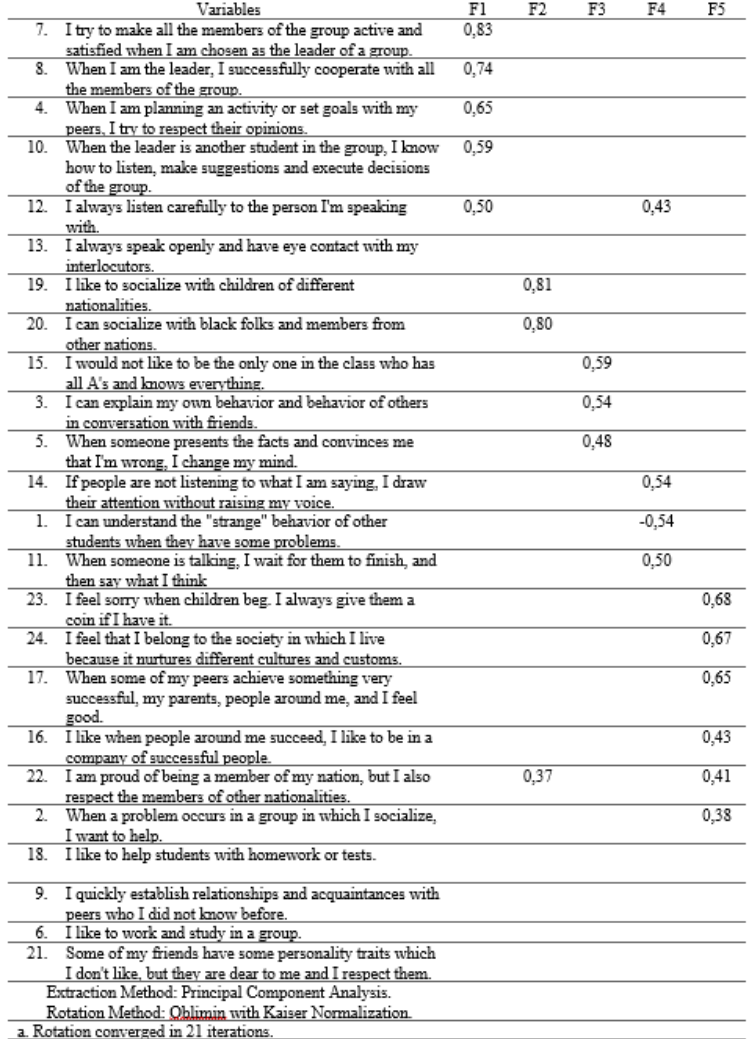
Table 4. Pattern